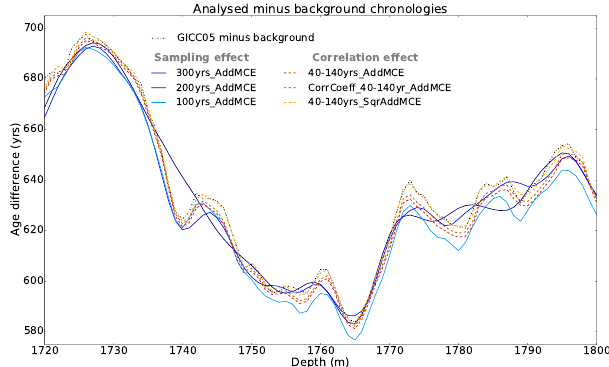
Figure 4. Sensitivity of the age and error solution to sampling of duration constraints and to the MCE assumptions. The difference between analysed chronologies and GICC05 age scale are shown in the top panel. Analysed errors and MCE are plotted in the bot- tom panel. The simulations settings are (i) three different uniform sampling rates (300, 200 and 100 years) and (ii) three adaptive sam- plings ranging from 40 to 140 years. The marker errors are derived under the AddMCE assumption (full correlation between annual cy- cles), except for (i) simulation 40–140yr_SqrAddMCE, which is run under the SqrAddMCE assumption (correlation cut-off above 20 years), and (ii) simulation CorrCoeff_40–140yr_SqrAddMCE, which is run with a finite depth range correlation coefficient. Ta- ble 1 summarizes experiment configurations.